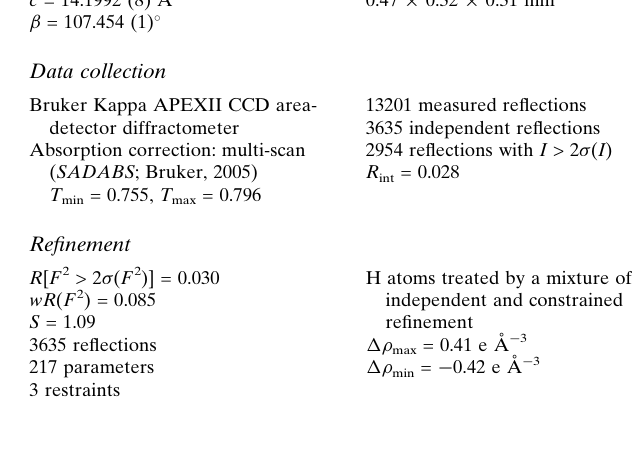
Data collection Bruker Kappa APEXII CCD area- detector diffractometer Absorption correction: multi-scan ( SADABS ; Bruker, 2005)